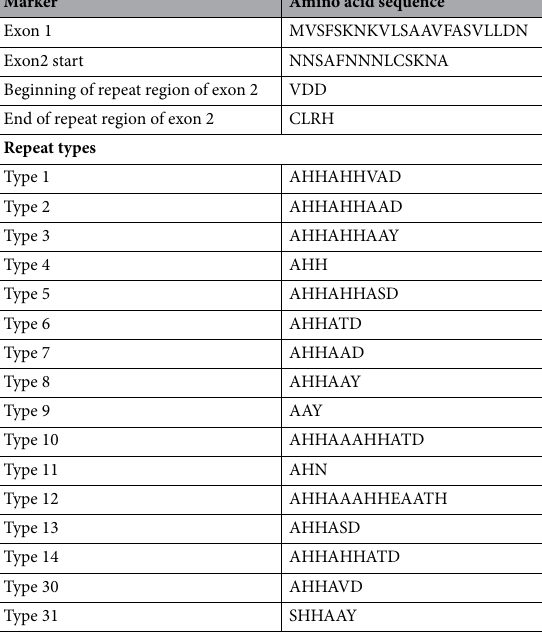
Table 1. Amino acid sequence markers for pfhrp2 . These markers were used as guide for correctly framing the pfhrp2 sequences for translation. Not all repeat types are present in all positive samples. The region between amino acid sequences VDD and CLRH was considered the repeat region of exon 2 and inspected for repeat